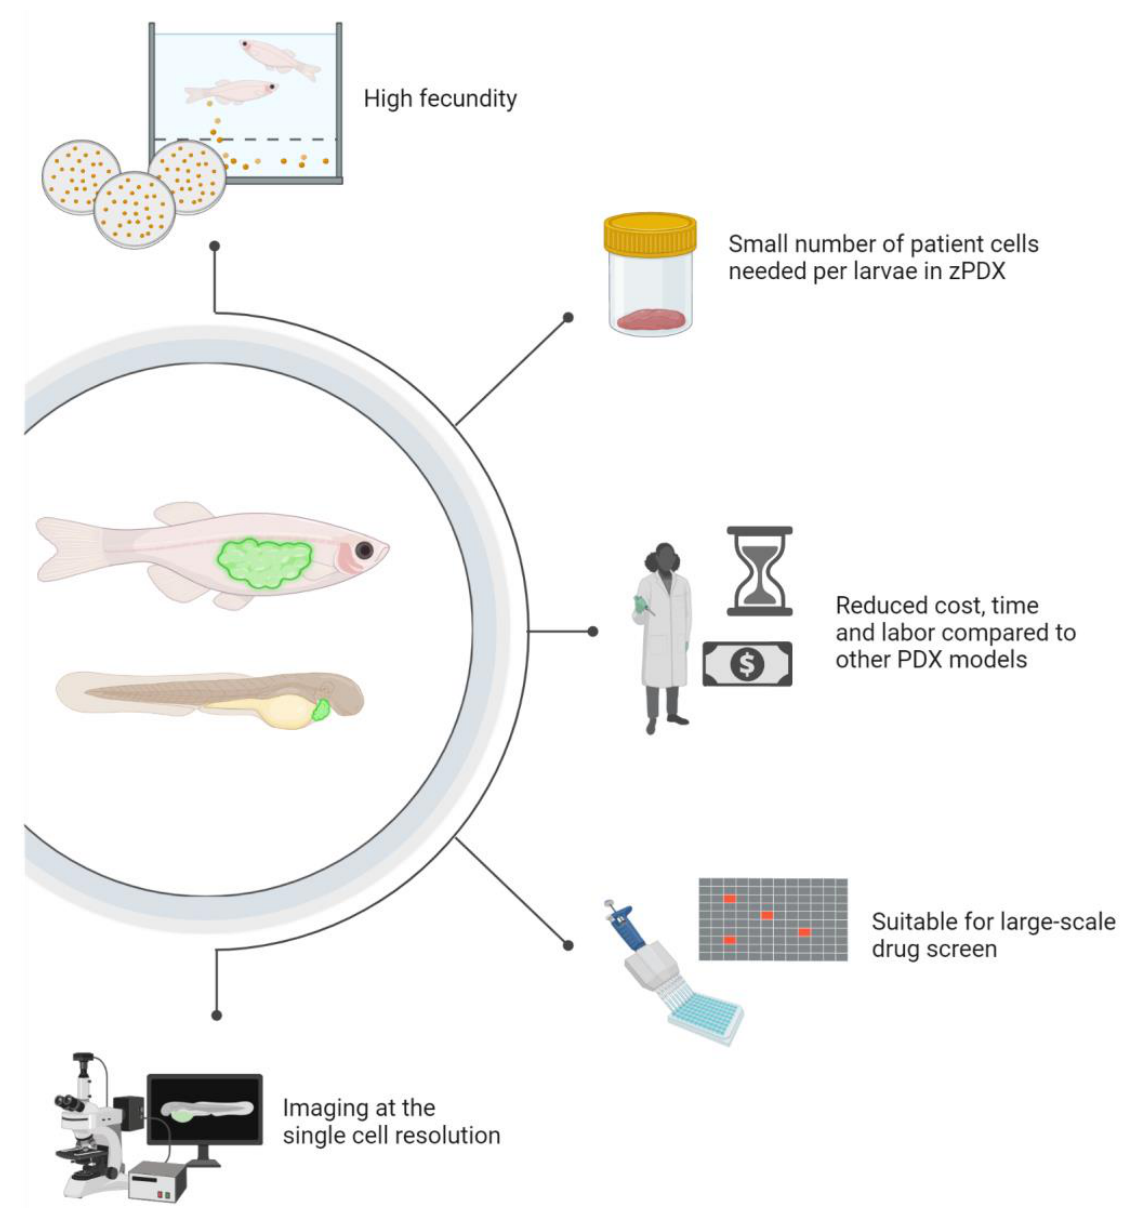
Figure 2. Unique features of the zebrafish make them powerful candidates for use as cancer patient avatars. From the top, clockwise: Zebrafish are highly fecund, with a mating pair generating hundreds of offspring per week for use in experiments. Larval zPDX can be generated with just hundreds of cells when patient material is limited. The low cost, labor and time required to generate zPDX, coupled with the available automation techniques, make zebrafish useful for drug screens to identify effective candidate treatments among many available therapeutics. Finally, the optical clarity of the zebrafish Casper stain makes them excellent for high-resolution imaging down to a single- cell level.